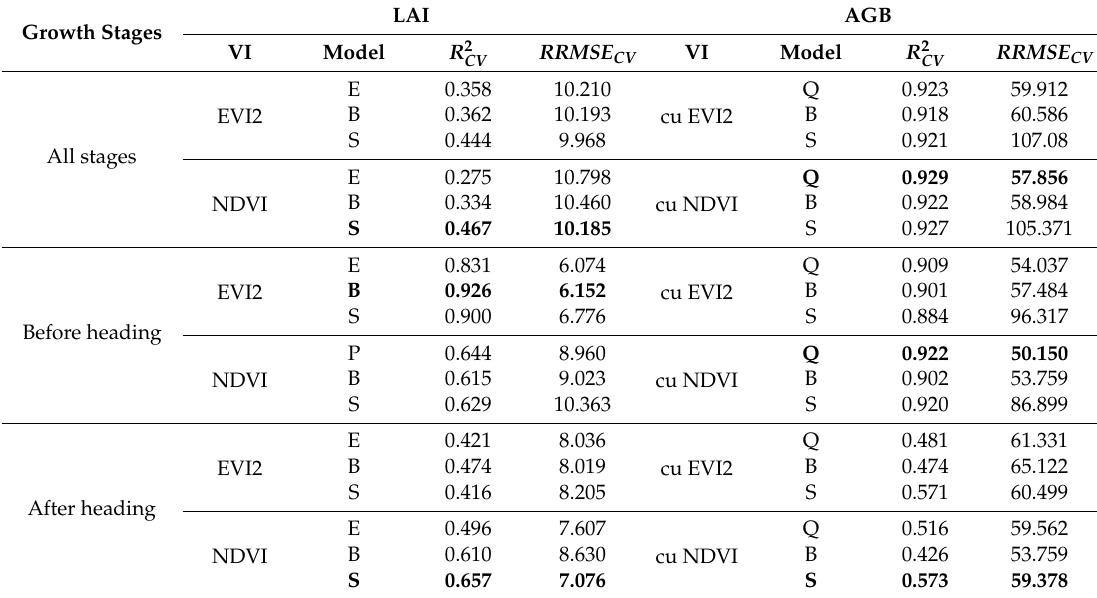
Table 4. Results of regression models at different single-cropped rice (SCR) growth stages. Growth